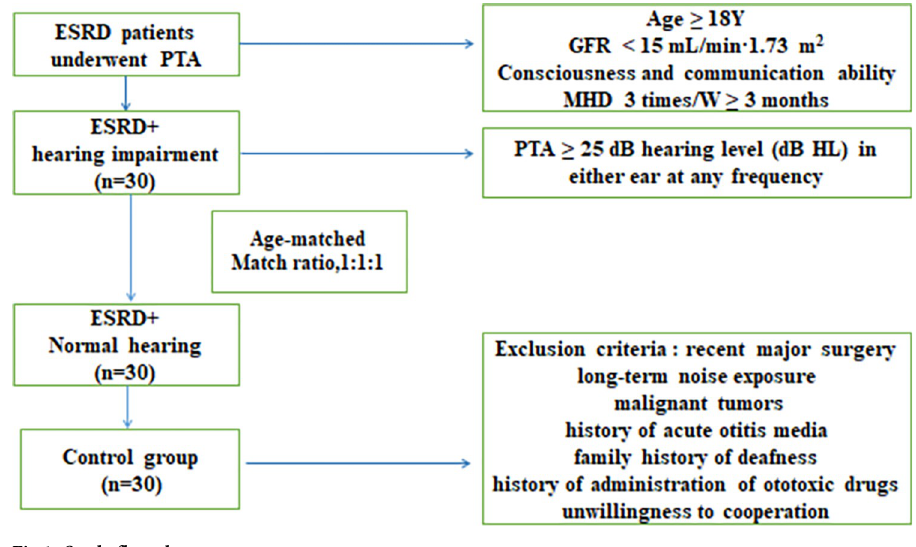
Fig 1. Study flow